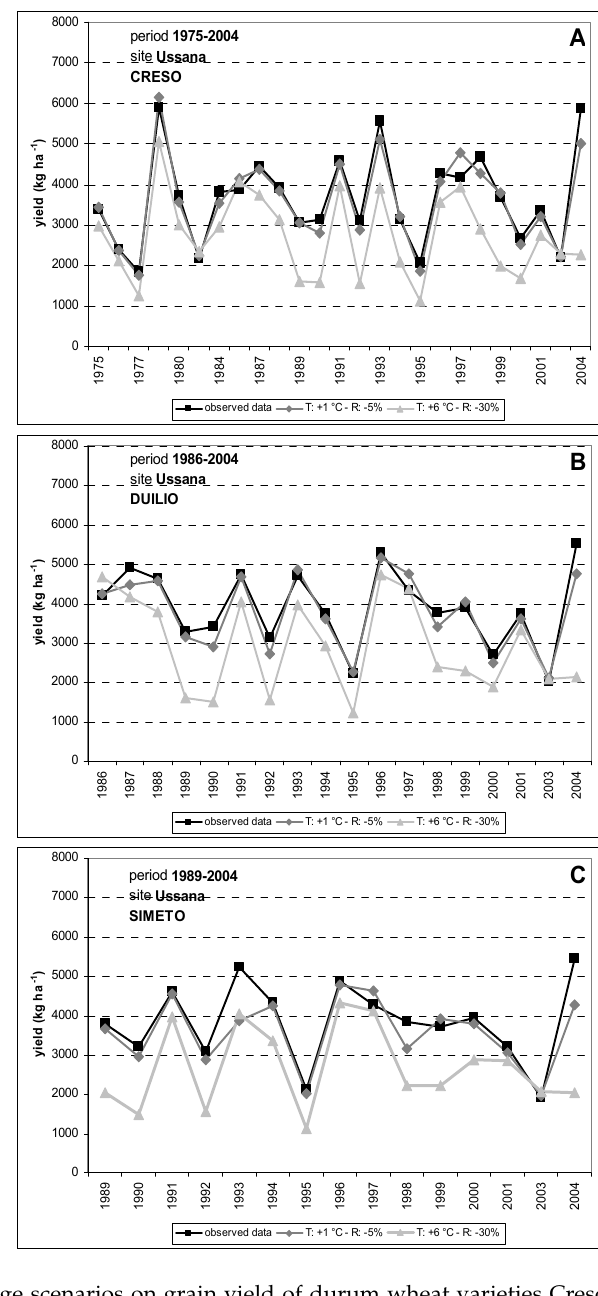
Figure 3. Effects of climate change scenarios on grain yield of durum wheat varieties Creso ( A ), Duilio ( B ), and Simeto ( C ) at Benatzu and Ussana sites. Simulation results from scenarios T1_R5 (temperature increase: +1 °C; rainfall reduction: 5%) and T6_R30 (temperature increase: +6 °C; rainfall reduction: 30%) are compared to observed yield data.